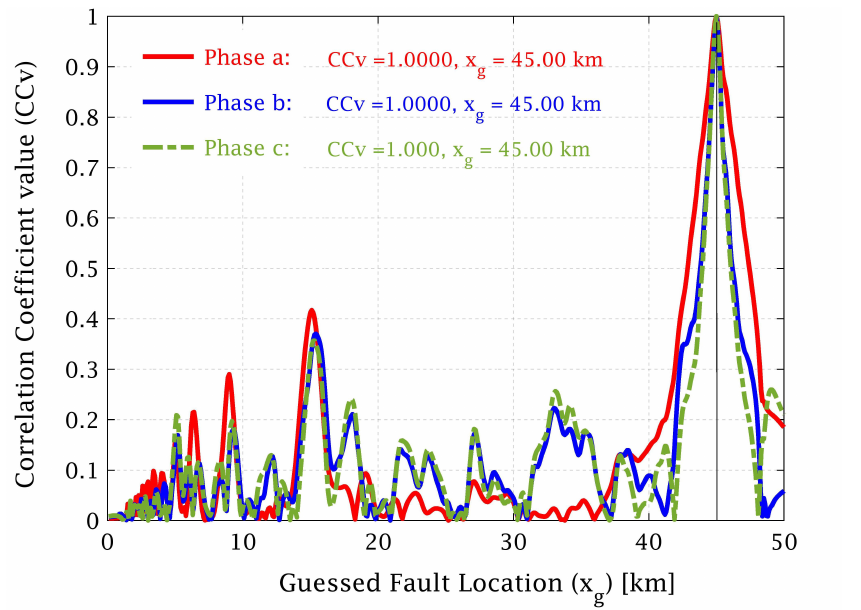
Figure 15. CCvs as a function of the GFL ( x g ): the fault is considered In Phase “a” at 45 km and estimated in all three phases, while the correlation between the H fos and H fes of the Phase “a” fault type scenario is